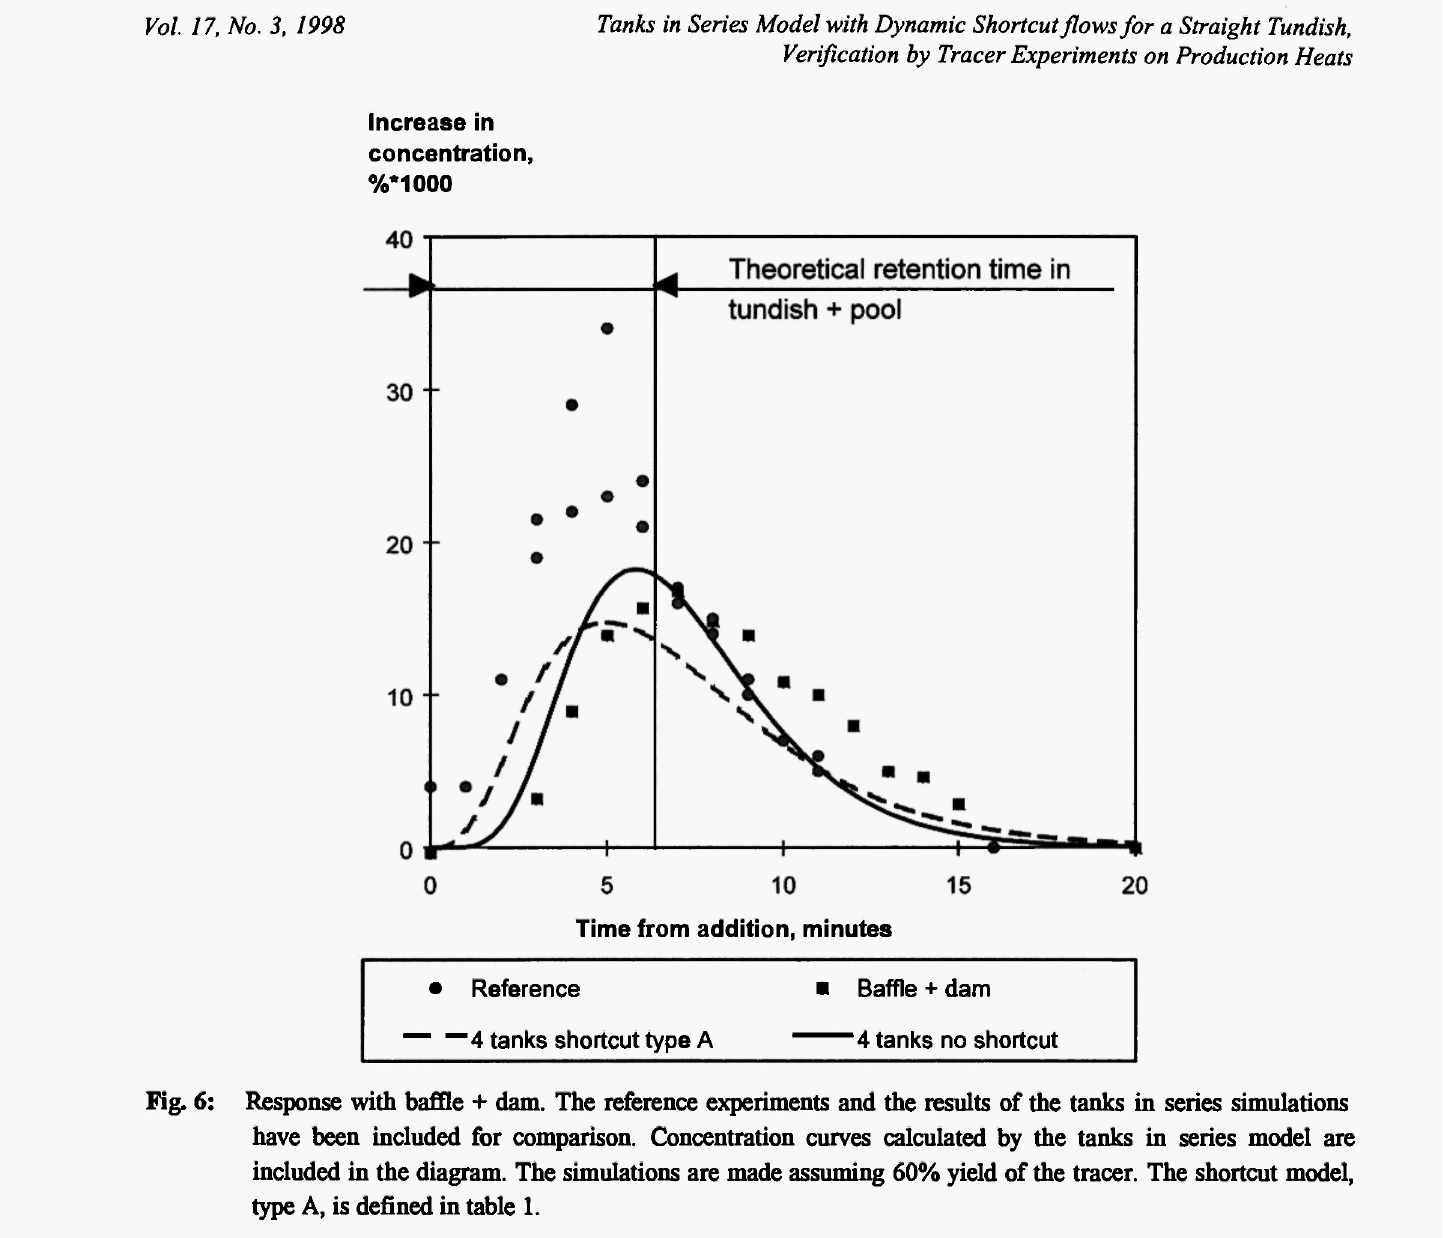
Response with baffle + dam. The reference experiments and the results of the tanks in series simulations have been included for comparison. Concentration curves calculated by the tanks in series model are included in the diagram. The simulations are made assuming 60% yield of the tracer. The shortcut model, type A, is defined in table 1. included in the diagram. The response without shortcut gives a better approximation than that with shortcut. the measured and calculated